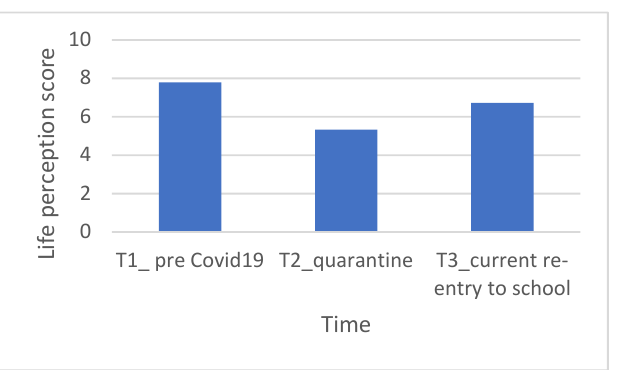
Figure 1. Estimated marginal means of Cantrill ’ s life perceptions in the neurotypical group. Leg- end: T1 = Life September 2019; T2 = Life in quarantine; T3 = Life-related to return to everyday